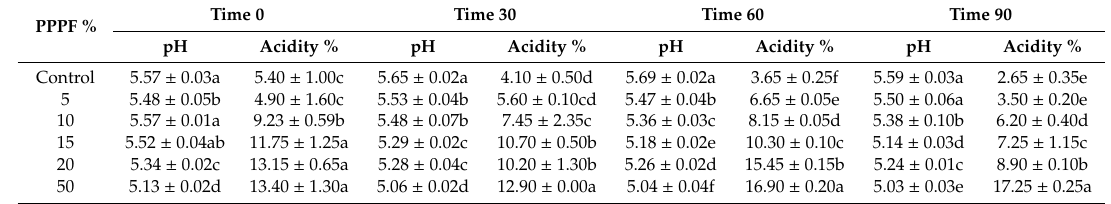
Table 4. pH and titratable acidity of dough samples content in bread samples at di ff erent times of